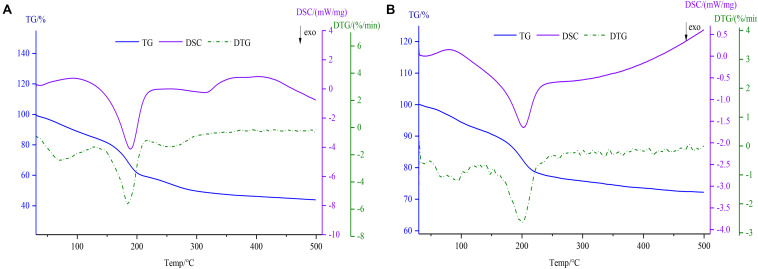
TG-DSC-DTG curves of GO (A) and Fe3O4@GO (B).